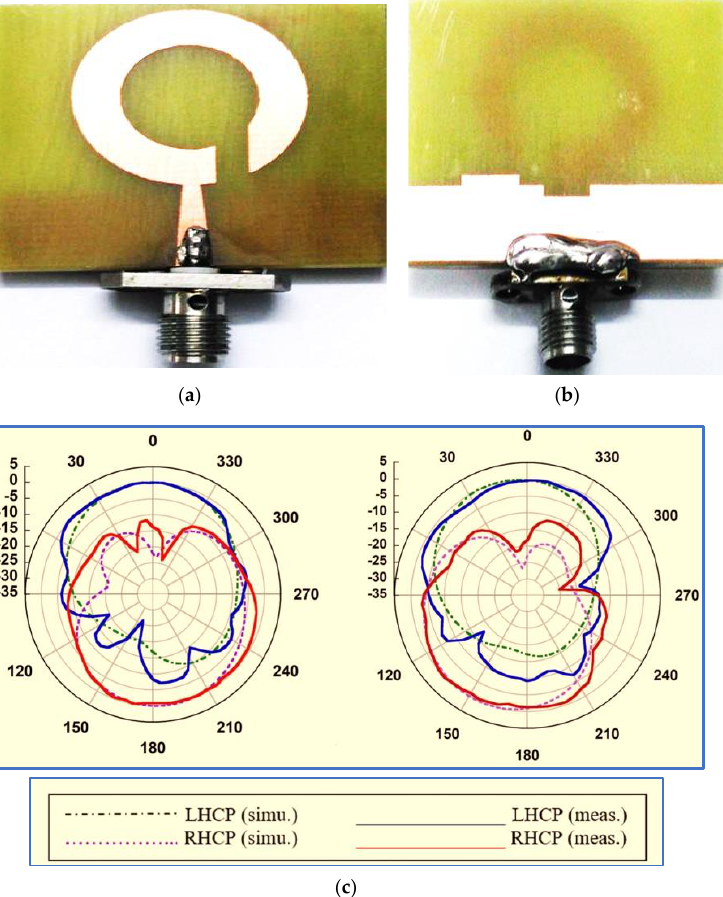
Figure 20. A microstrip-fed monopole: ( a ) front side; ( b ) back view; ( c ) measured radiation patterns at 5.2 GHz [117].